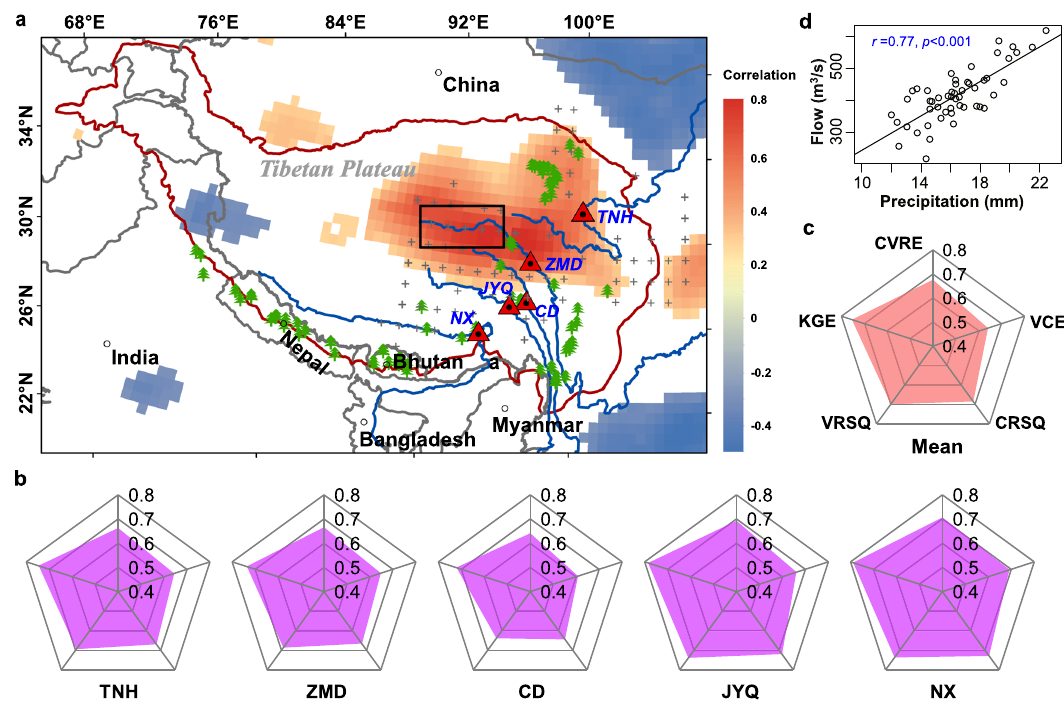
Fig. 1 | Study region and cross-validation resultsat fi ve gauging stations. a The red line shows the domain of the Tibetan Plateau. Red triangles denote gauging stations in headwater regions, i.e., from north to south, Tangnaihai (TNH) on the YellowRiver,Zhimenda(ZMD)ontheYangtzeRiver,Changdu(CD)ontheLancang- Mekong River, Jiayuqiao (JYQ) on the Nu-Salween River, and Nuxia (NX) on the Yarlung Zangbo-Brahmaputra River. Grey + symbols denote locations of Palmer Drought Severity Index (PDSI) predictors used in this study. Green trees denote open-sourced tree-ring chronologies located in or surrounding the South and East Tibetan Plateau (SETP). Shaded areas represent signi fi cantly correlated areas at a